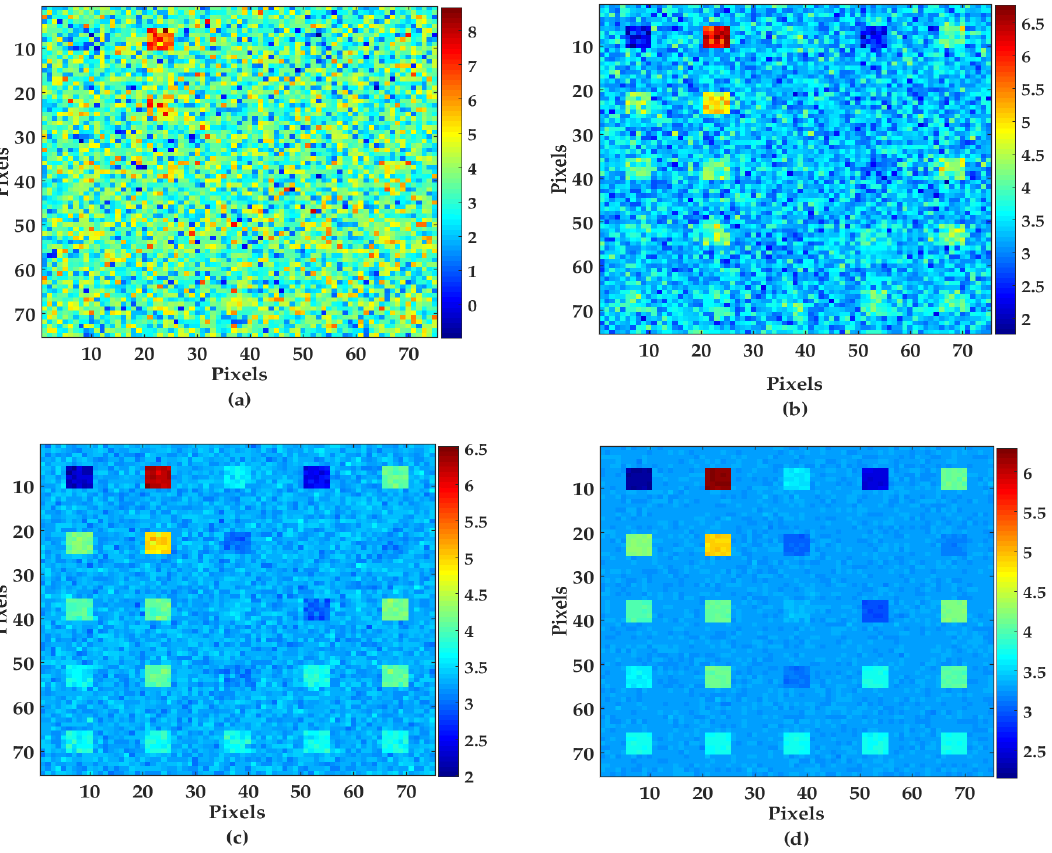
Figure 1. Band 100 at (2200 nm) of the pixelwise reflectance estimate adding random sensor noise to the at-sensor radiance with SNR ( a ) 30 dB; ( b ) 40 dB; ( c ) 50 dB and ( d ) 60 dB. The size of all the synthetic images is 128 × 128 pixels with B = 126 spectral bands and the spatial resolution of 2.5 m along track and 2.0 m across track. All synthetic images obey the linear